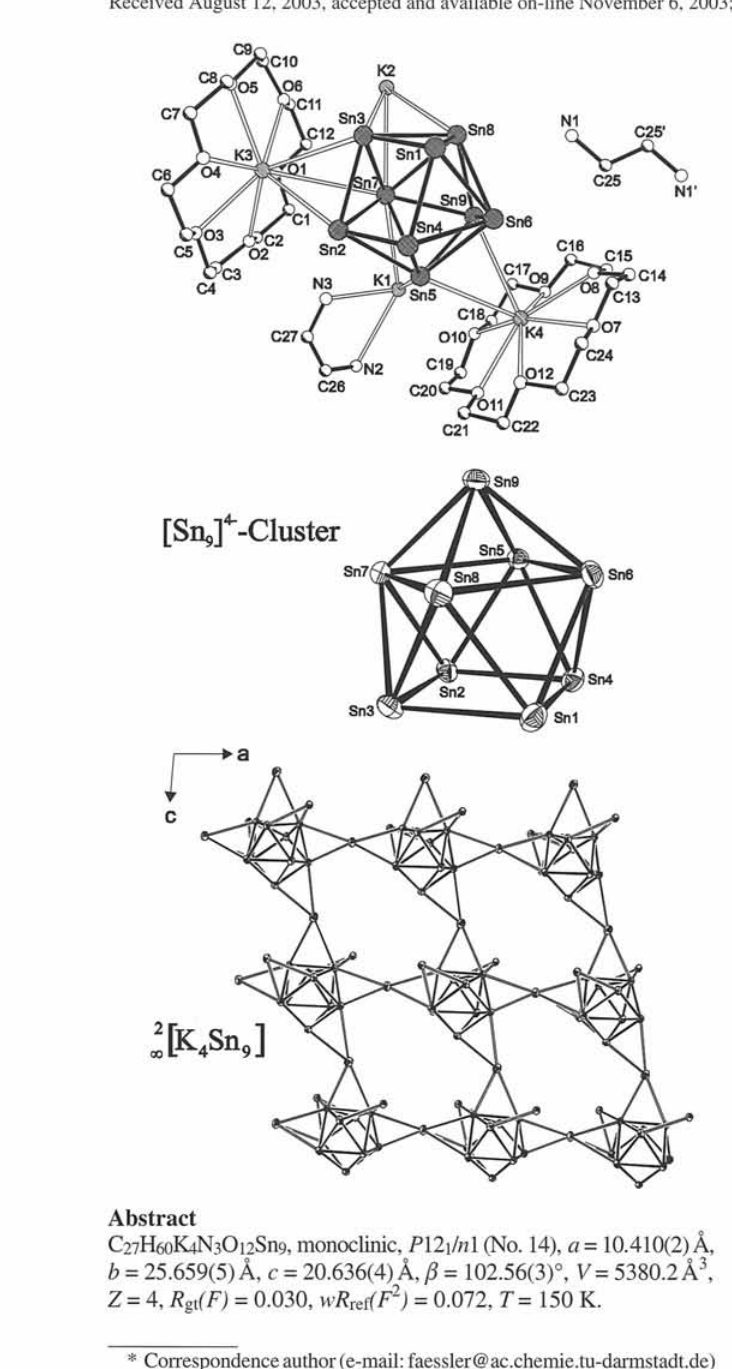
Table 1. Data collection and handling.